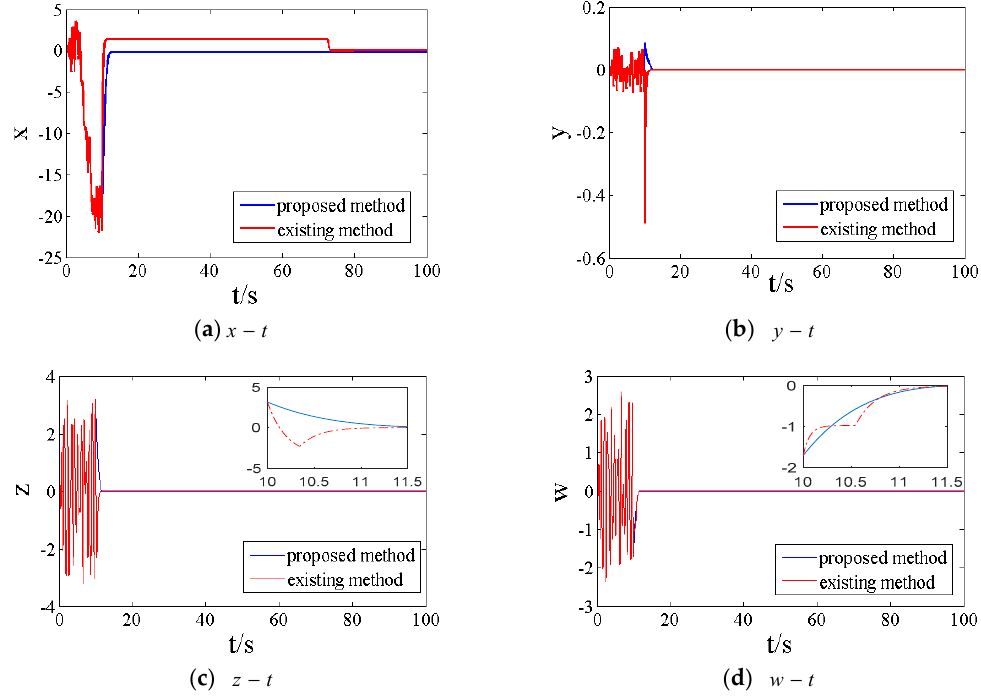
Figure 5. State responses with controllers (40) and (43). ( a ) x t − ; ( b ) y t − ; ( c ) z t − ; ( d ) w t − .